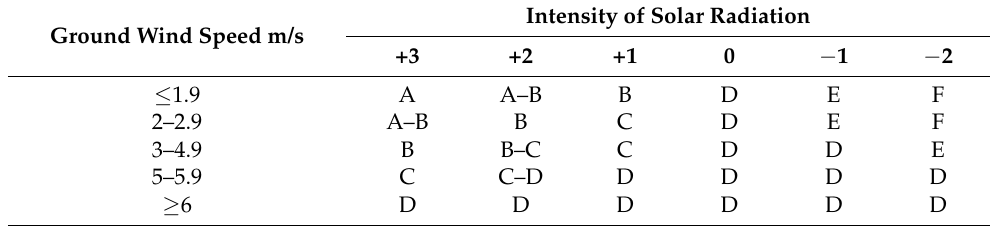
Table 2. Grade of atmospheric stability.